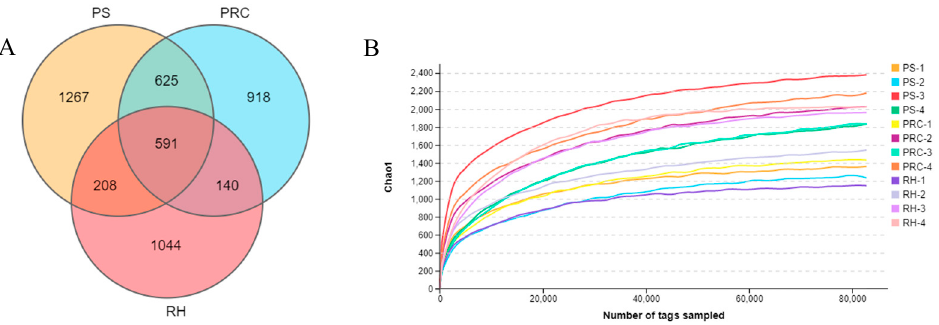
Figure 2. Venn diagram showing the number of unique and shared operational taxonomic units (OTUs) ( A ). High-throughput sequencing tag numbers and sequencing depth ( B ). PS = peanut shells, PRC = peanut–rice combination, RH = rice husks.